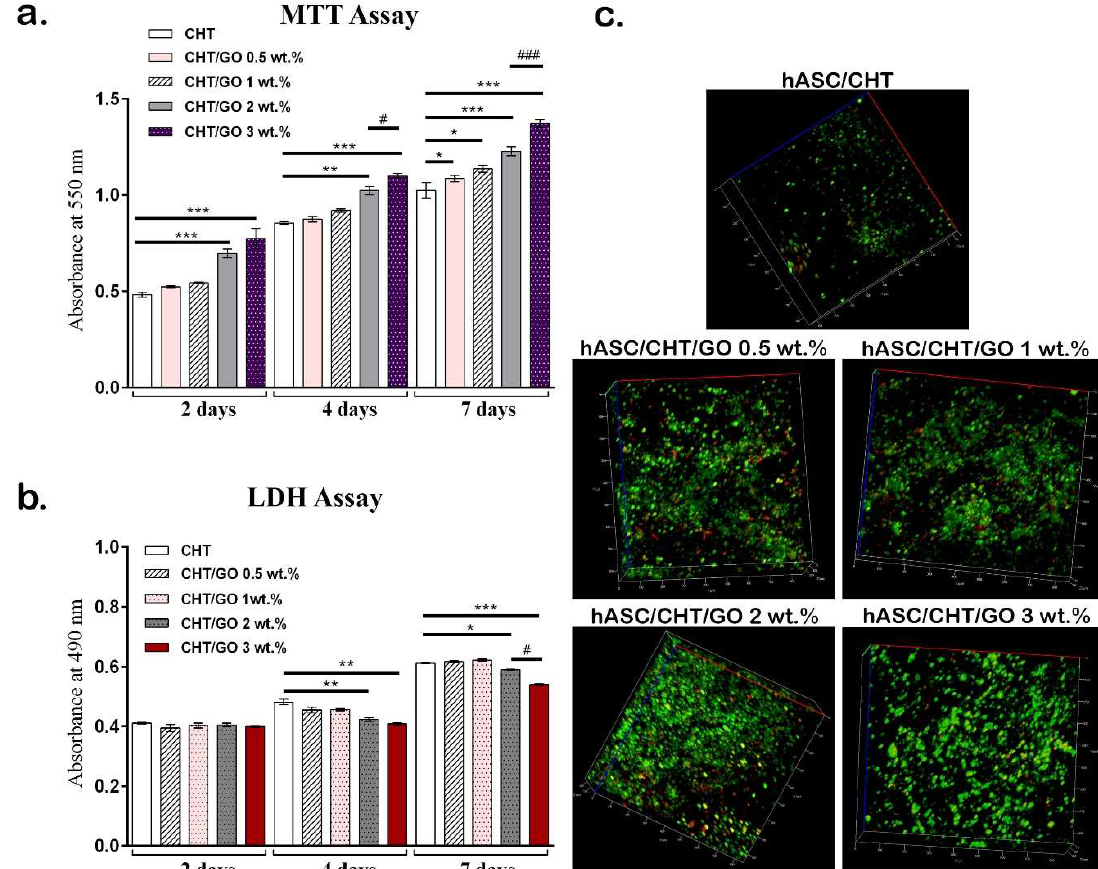
Figure 1. Cytocompatibility assessment of BC0.5–BC3 with human adipose-derived stem cells (hASCs). ( a ) Cell viability in contact with chitosan (CHT) / graphene oxide (GO) composites by 3-(4,5-dimethylthiazol-2-yl)-2,5-diphenyltetrazolium bromide (MTT) assay; ( b ) CHT / GO material levels of cytotoxicity on contact with hASC culture by lactate dehydrogenase (LDH) assay; ( c ) tridimensional reconstructions for BC0.5-BC3 and control showing live cells (green) and dead cells (red) after 7 days of culture resulted from Live / Dead assay and confocal microscopy analysis. * / # p < 0.05; ** p < 0.01; *** / ### p < 0.001.